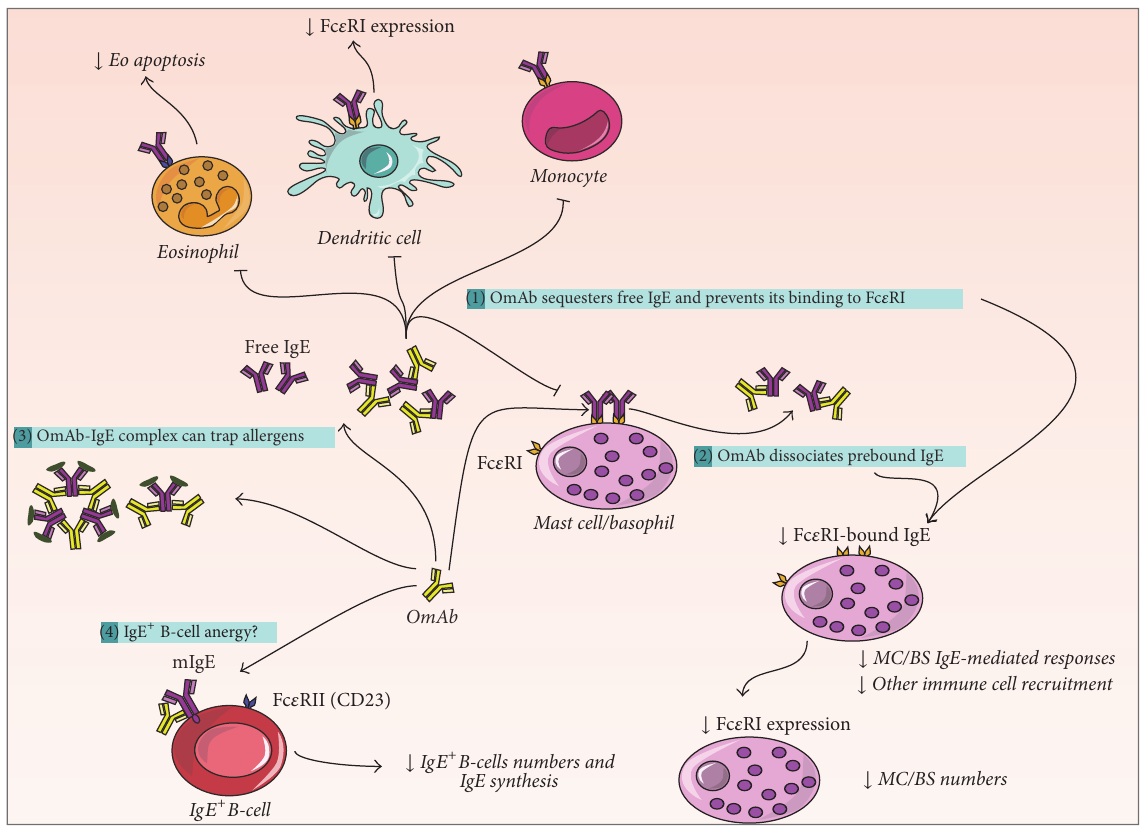
Figure 3: Mechanism of action of OmAb. The two main described mechanisms of action of OmAb are (1) its ability to sequester free IgE and block its binding to IgE receptors (Fc 𝜀 RI) and (2) its ability to accelerate the dissociation of IgE bound to Fc 𝜀 RI in mast cells (MC) and basophils (BS). As a consequence, there is a reduction of IgE-triggered responses, as well as a reduction of the number of eosinophils (Eo), mast cells (MC), and basophils (BS). As a complementary mechanism, IgE complexed with OmAb may trap allergens (3). Another less understood mechanism would lead to a reduction of IgE + B-cell numbers and a decrease of IgE synthesis (4). mIgE: membrane